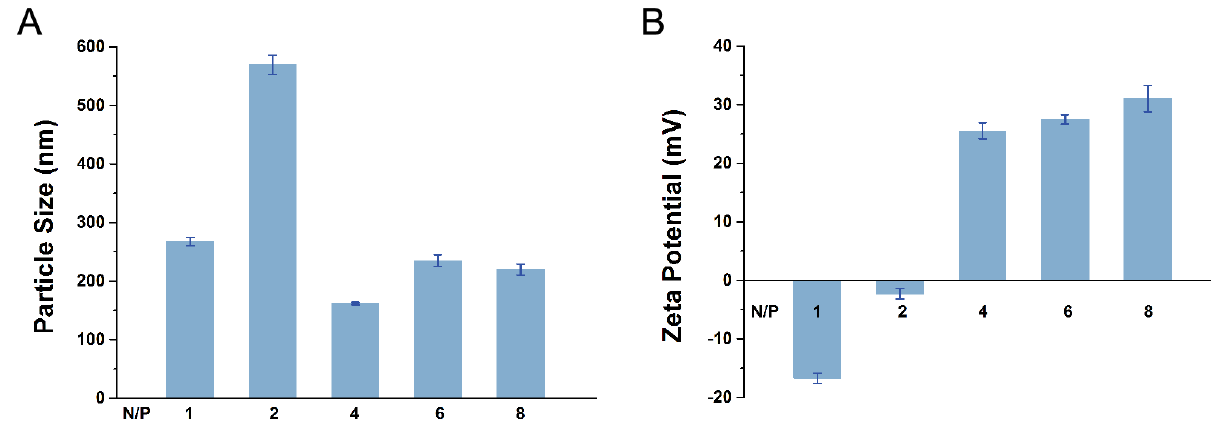
Figure 3. Changes in particle sizes ( A ) and zeta potentials ( B ) of the lipoplexes, along with the increases in N/P ratios. Data represent mean ± SD ( n = 3).